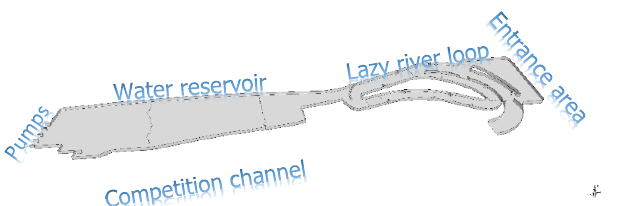
Figure 6. Overall geometry of the